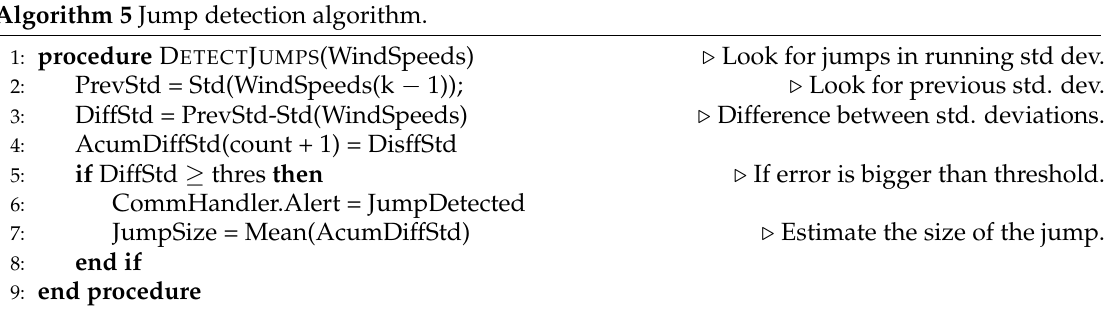
Algorithm 5 is used for detection of anomalies in the running standard deviation. Algorithm 5 Jump detection